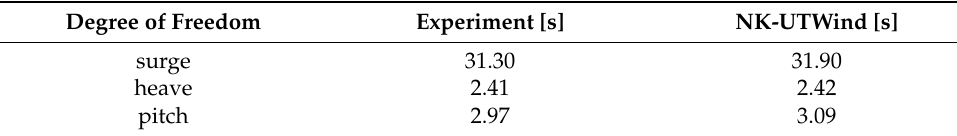
Table 5. Natural periods obtained from free decay tests.